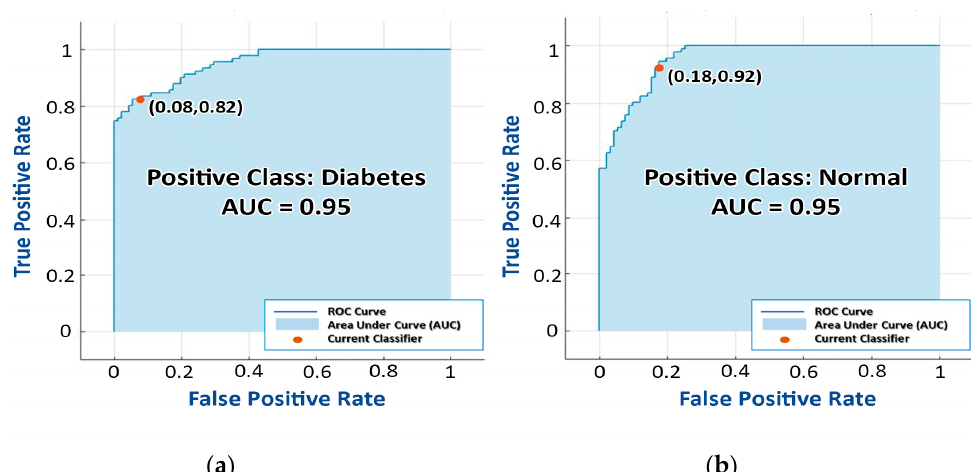
Figure 17. ROC curve for super vector machine classifier during training: ( a ) positive-class diabetes; ( b ) positive-class normal.